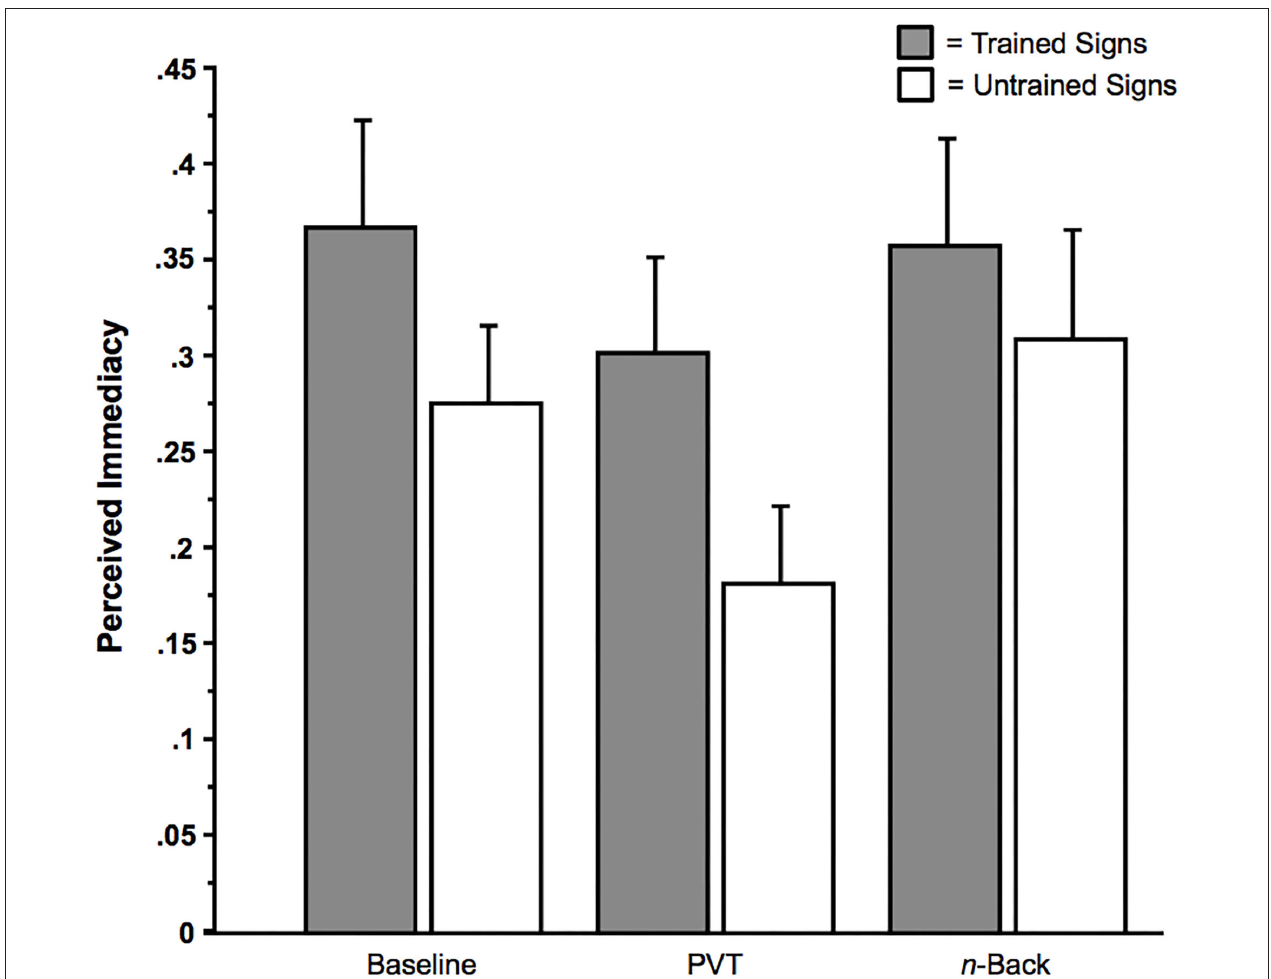
FIGURE 7 | Perceived immediacy of involuntary imagery as a function of Sign Type (Trained vs. Untrained [Control]) and Multi-Tasking (None [Baseline], Psychomotor Vigilance Task [PVT], or n -back). Error bars indicate SE s.